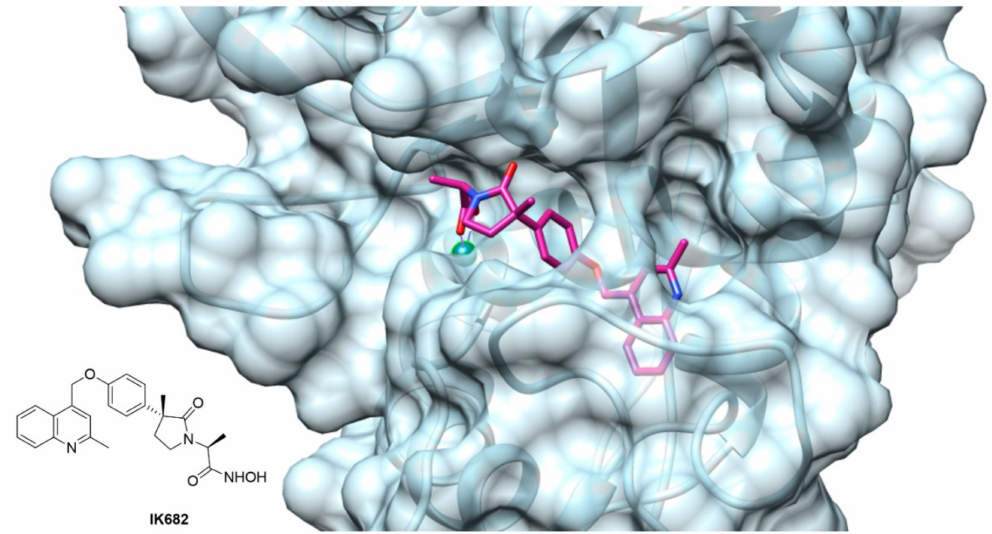
Figure 4. ADAM17 catalytic binding site complexed with compound IK682, a DPC-333 analogue [179] (PDB: 2FVS. Image created using Chimera, version